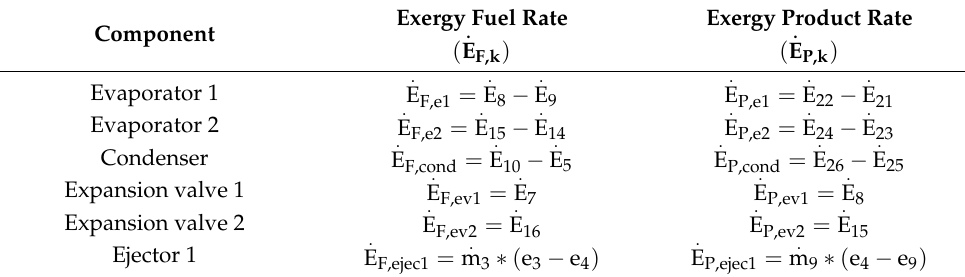
Table 3. Exergy balance